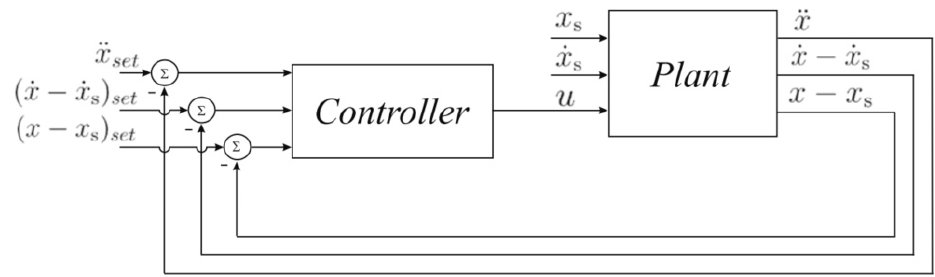
Figure 6. Schematic of the triple feedback loop controller [52].